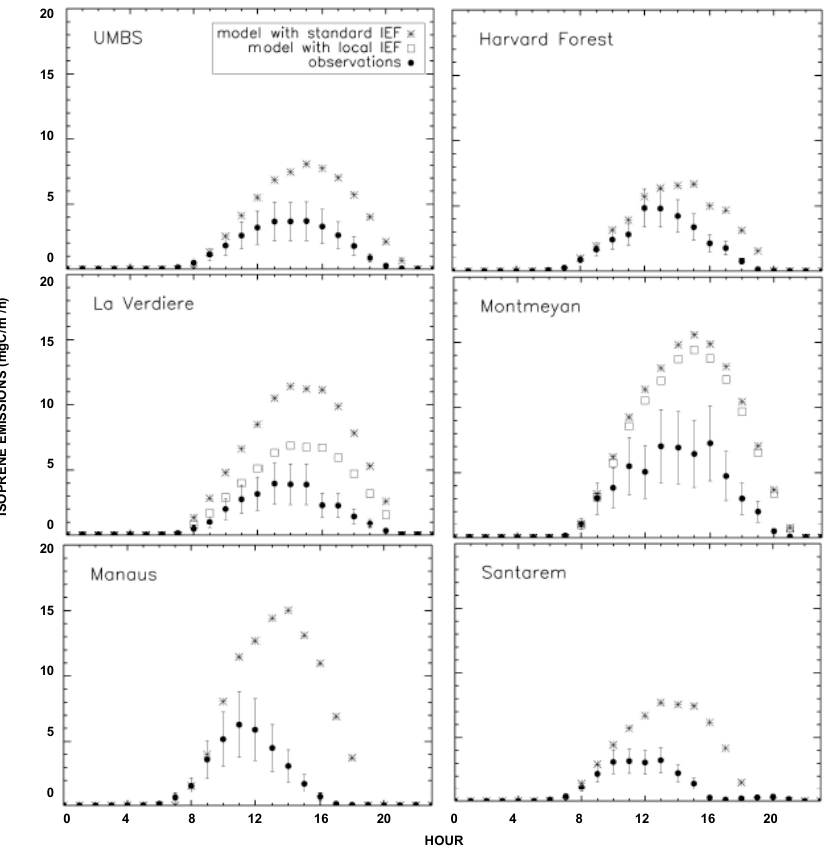
Fig. 1. Comparison of simulated and ground-based measured mean diurnal cycles of isoprene emissions at the flux tower sites listed in Table 1. Isoprene emissions were simulated using standard IEFs from Guenther et al. (1995) and local IEFs when